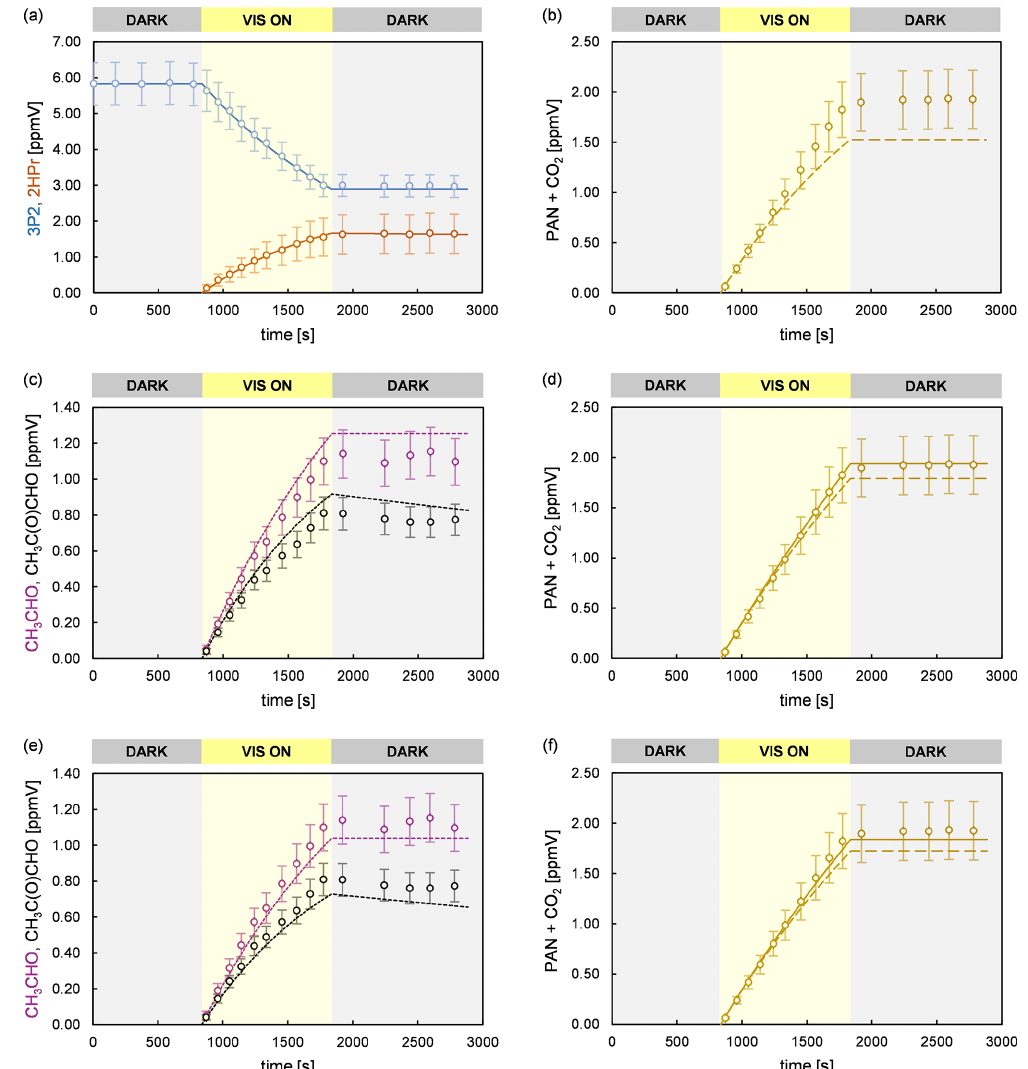
Figure 8. Experimental (circles) and simulated (lines) temporal behaviour of 3P2, 2HPr, acetaldehyde, methyl glyoxal, and PAN + CO 2 in an experiment performed in the 480L chamber. The error bars of the experimental data represent the accuracy error. Model runs of the sum parameter PAN + CO 2 are shown considering only the formation of PAN and CO 2 due to CH 3 C(O) radicals formed in the reaction system (dashed line) and including additionally the CO 2 source from 2HPr + OH (solid line). The model run in panel (b) considers only primary PAN and CO 2 formation from 3P2 + OH. Panel (c) and (d) represent model runs according to scenario 3 (acetaldehyde and methyl glyoxal at the upper limit of the accuracy error), and panel (e) and (f) represent those according to scenario 4 (acetaldehyde and methyl glyoxal at the lower limit of the accuracy error),